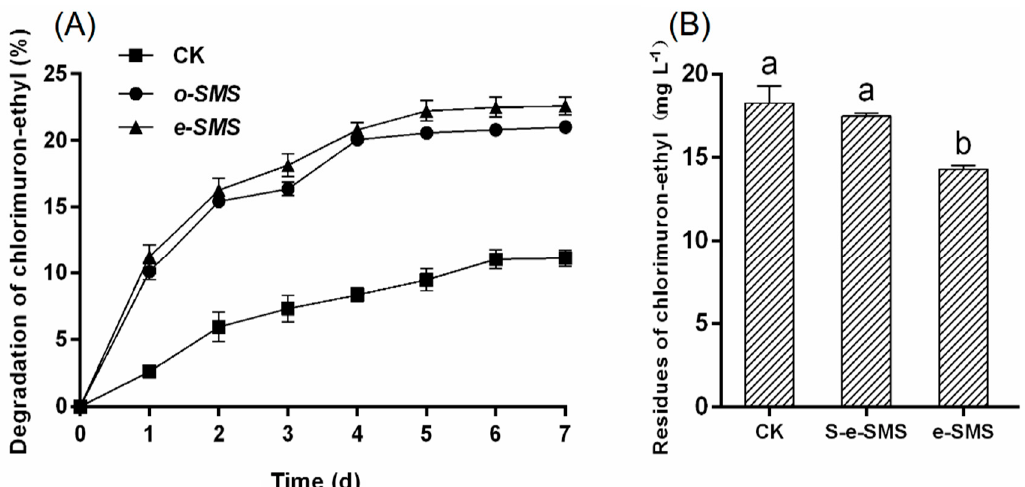
Figure 1. Selection of the carrier for the chlorimuron-ethyl-degrading co-culture bacteria. (A) Levels of chlorimuron-ethyl after treatment with crude extracts containing laccase from spent mushroom substrate (SMS). e-SMS: laccase crude extract from P. eryngiu SMS; o-SMS: laccase crude extract from P. ostreatus SMS. ( B ) Degradation of chlorimuron-ethyl by sterilized P. eryngiu SMS and unsterilized P. eryngiu SMS. S-e-SMS: sterilized P. eryngiu SMS; e-SMS: unsterilized P. eryngiu SMS. The bars represent the SDs of assays performed in triplicate.